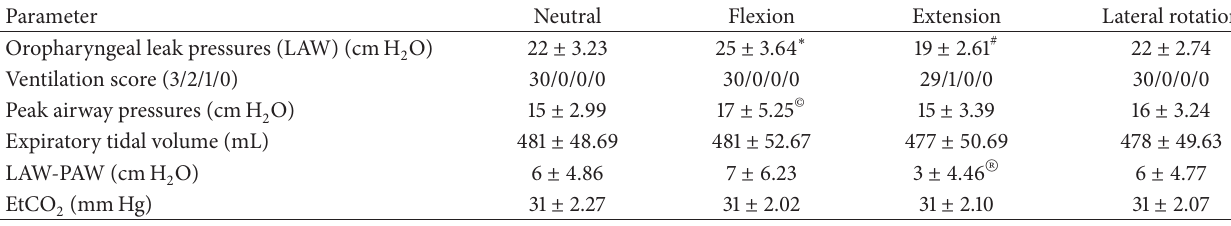
Table 4: Oropharyngeal leak pressures and ventilation with I-gel.